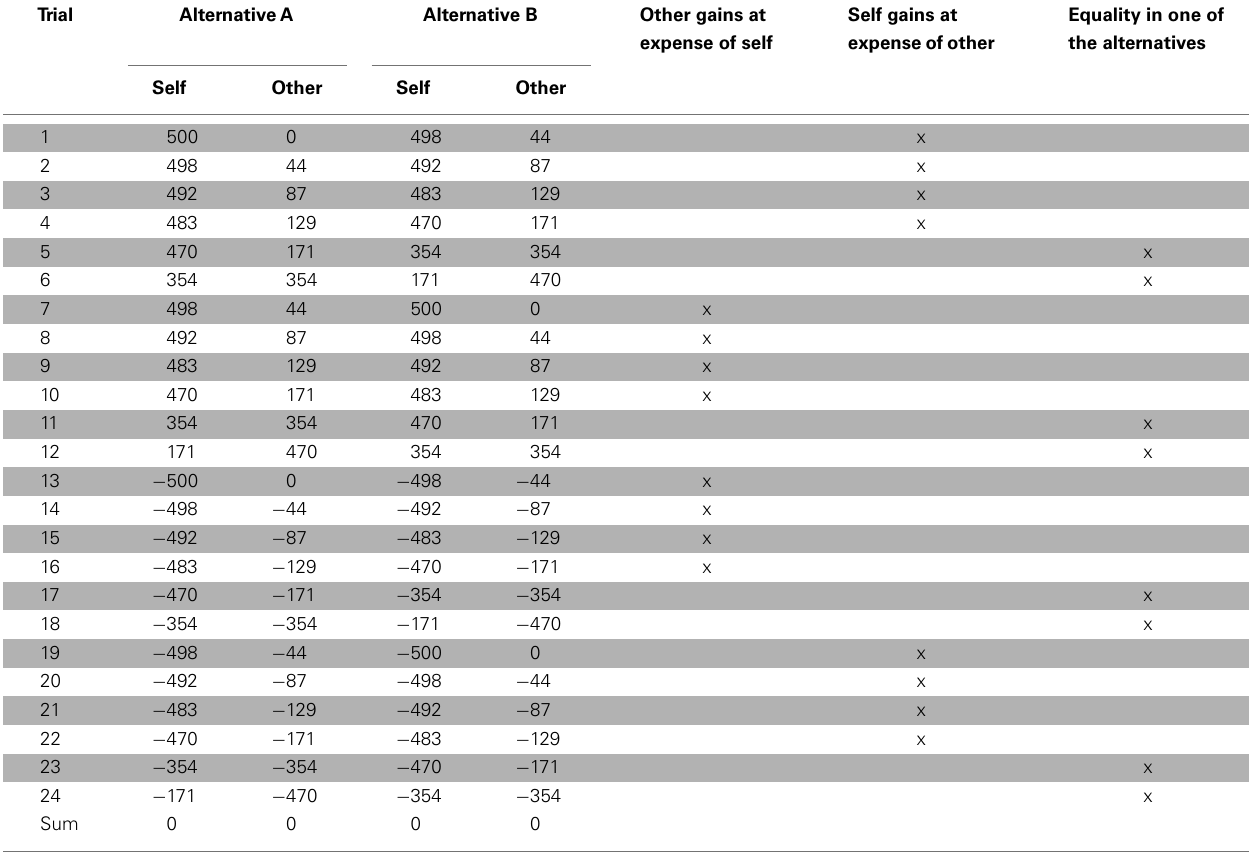
Table 1 |Alternatives during the scanned pre- and post-interaction distributional outcome test (DOT). Trial AlternativeA Alternative B Other gains at